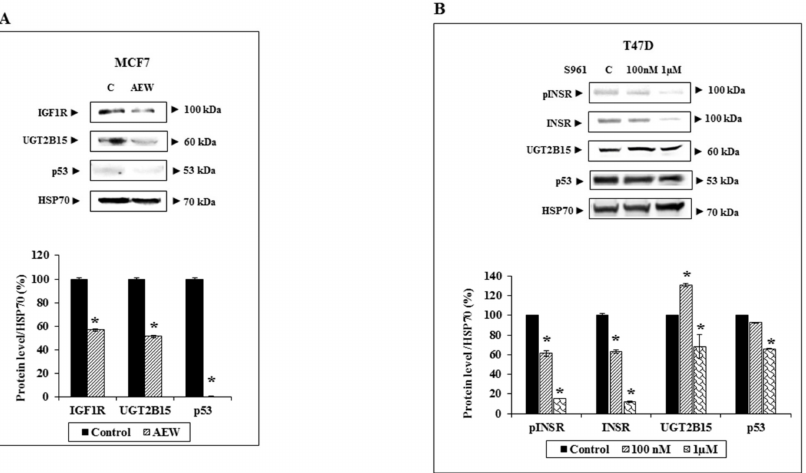
Figure 6. Effect of IGF1R and INSR inhibition on UGT2B15 gene expression. ( A ) MCF7 cells were treated with the selective IGF1R inhibitor AEW541 (10 mM) for 48 h (or left untreated, C), after which cells were harvested, total protein was prepared, and IGF1R, UGT2B15, and p53 levels were measured by Western blots. HSP70 levels were measured as a loading control. The bar graph denotes UGT2B15 and IGF1R levels in control (solid bars) and AEW541 treated cells (striped bars). ( B ) T47D cells were treated with the INSR inhibitor S961 (100 nM and 1 mM) for 2 h. Cells were then harvested and levels of phospho- and total-INSR, UGT2B15, and p53 levels were measured by Western blots. A value of 100% was given to control, untreated cells. * p <